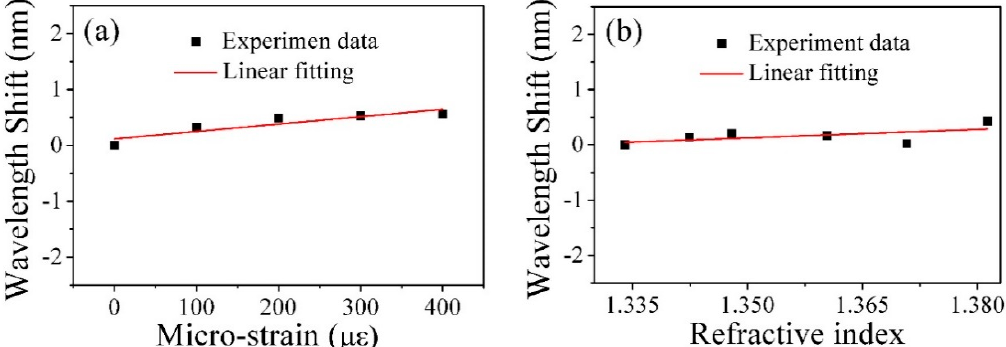
Figure 6. ( a ) Relationship between micro-stain and wavelength. ( b ) Relationship between RI and